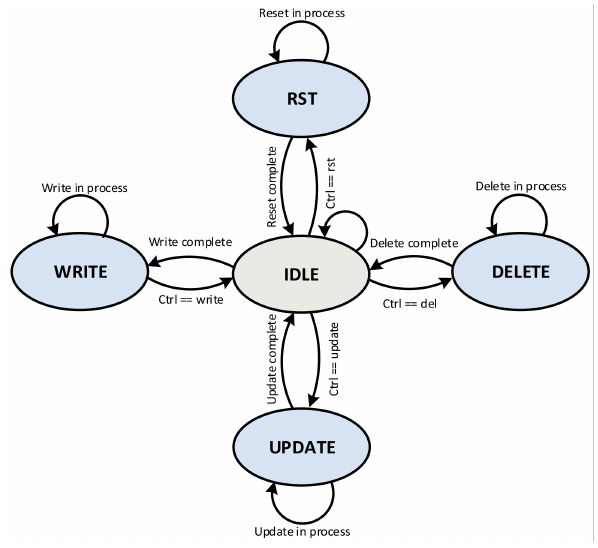
Figure 15. MAT configuration